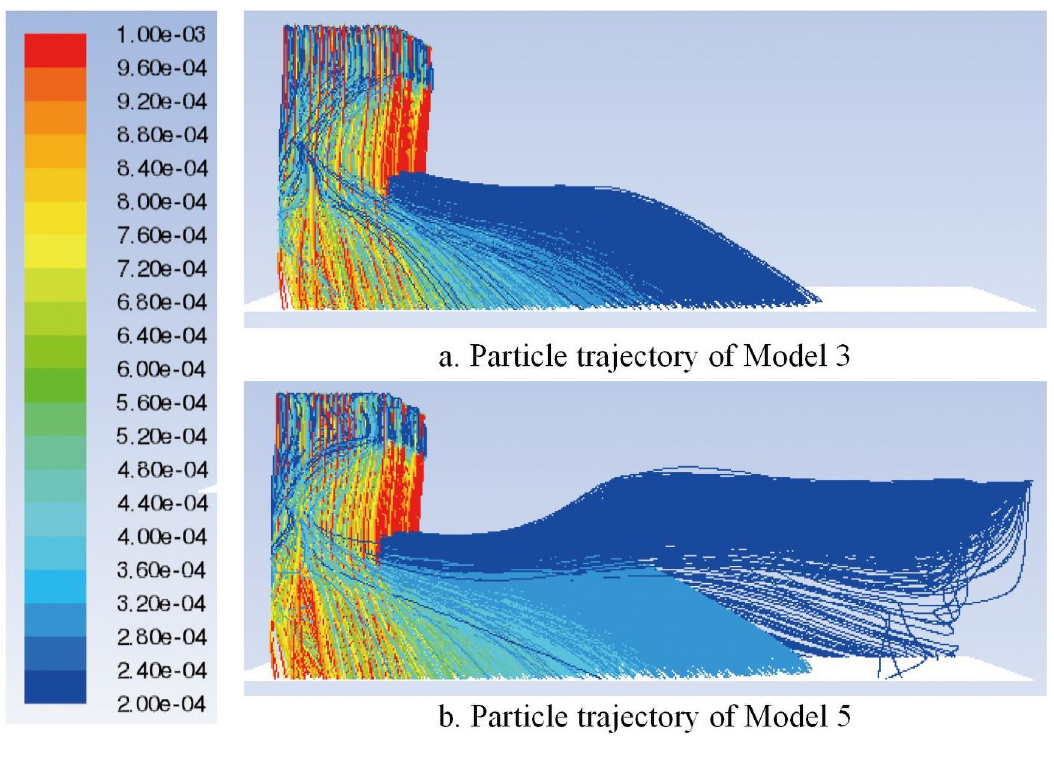
Fig 25. Particle trajectory of different box structures.